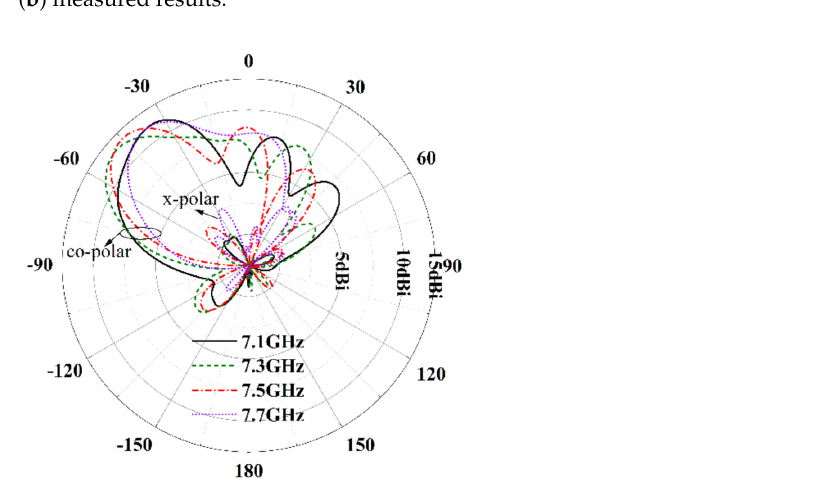
Figure 17. Simulated radiation patterns of the proposed antenna in YOZ plane.